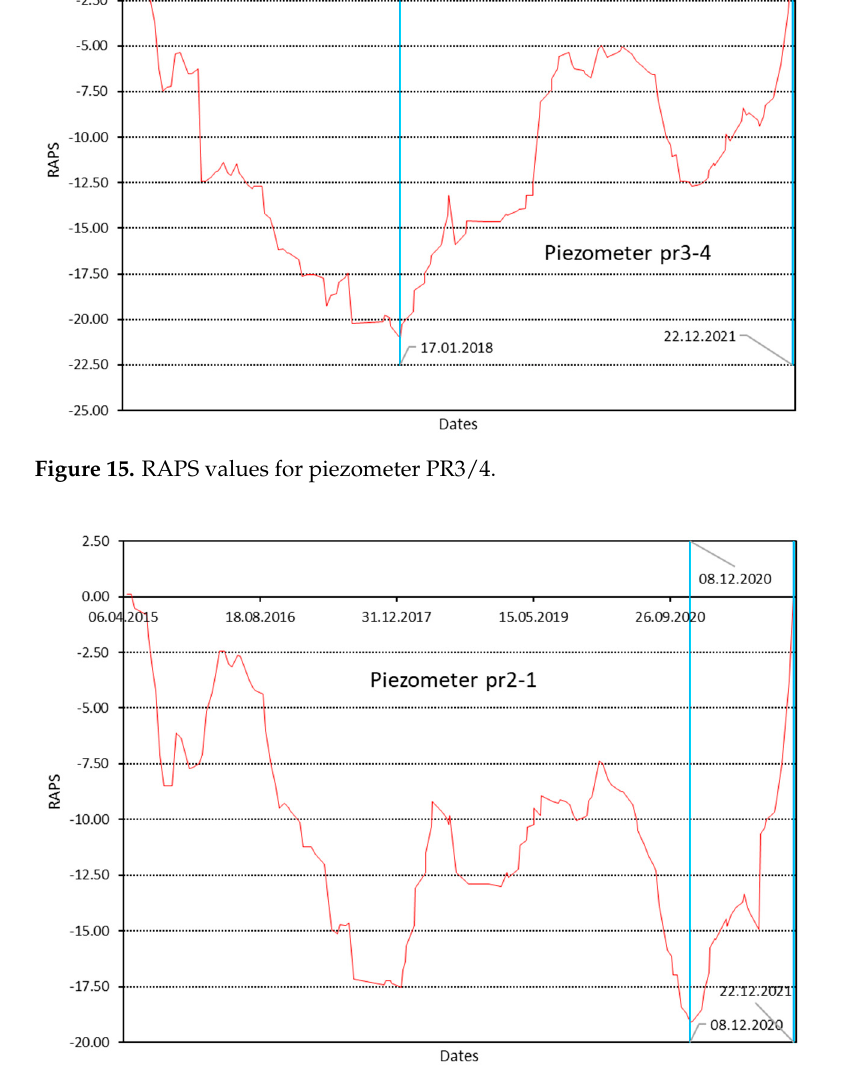
Figure 16. RAPS values for piezometer PR2/1.